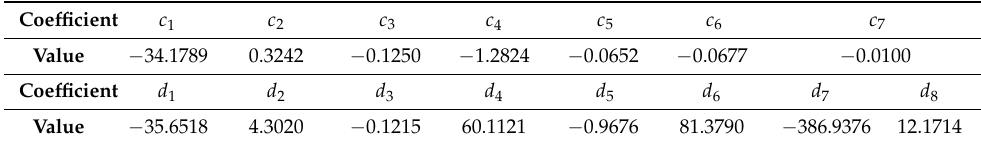
Table 4. The coefficients in Equation